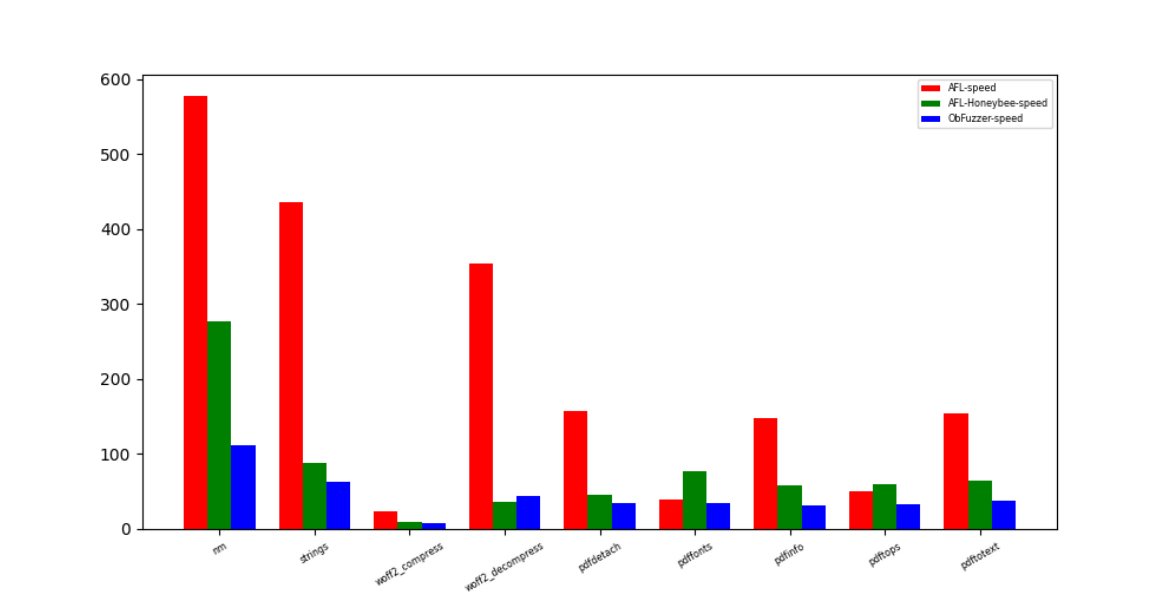
Figure 11. Execution Speed Average of AFL, AFL-Honeybee and ObFuzzer Fuzzing Phase. In Figure 11, the x -axis represents different programs and the y -axis represents the num- ber of executions per second. The red bar represents the number of executions per second of AFL, the green bar represents the number of executions per second of AFL-Honeybee and the blue bar represents the number of executions per second of the ObFuzzer fuzzing